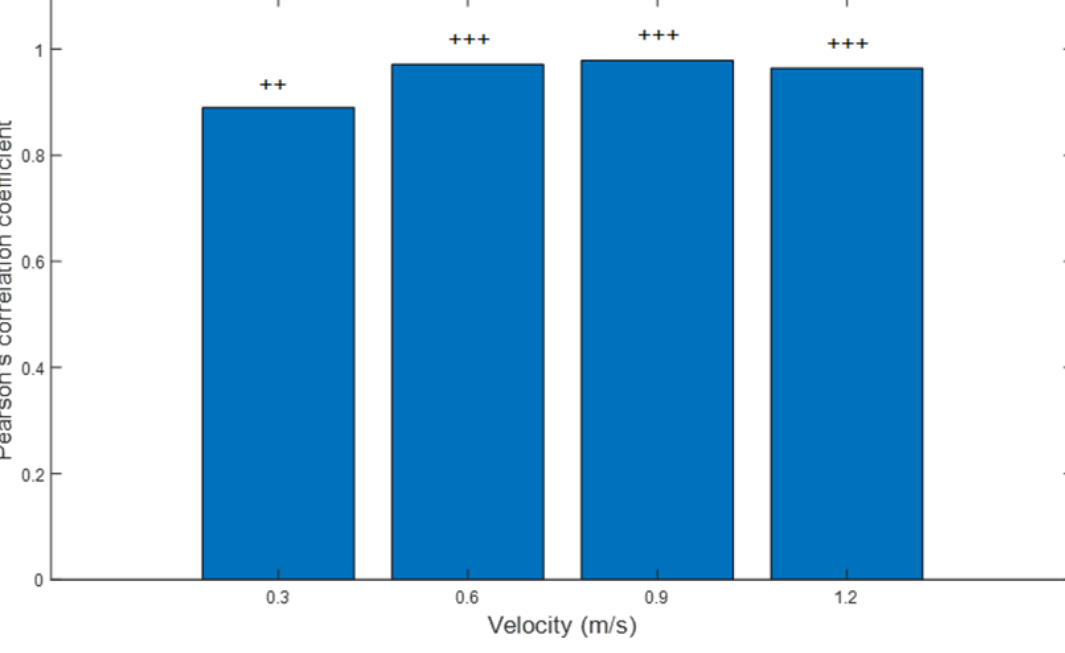
Figure 7. Pearson’s correlation between the number of right limb EMG peaks of medial gastrocnemius activity between two sessions of treadmill walking. Overall results indicate a good to excellent level of agreement All correlations were significant at p < 0.05. Correlation: ++ = high, +++ = very high.